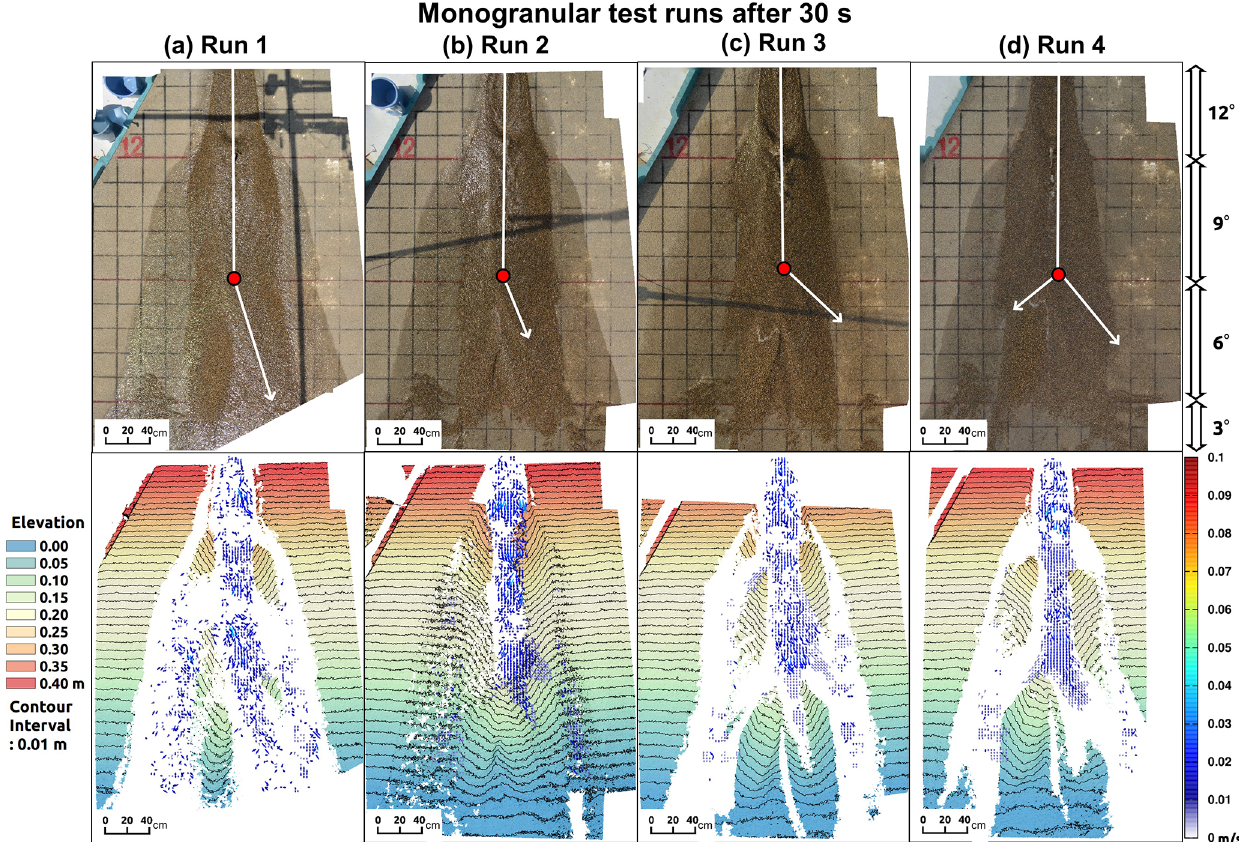
Figure 10. Fan morphology 30s after the start of runout of the monogranular flows. The upper and lower panels show orthophotos and digital elevation models (DEMs) with flow vectors, respectively. Respective sets of the upper orthophoto and lower DEM represent corresponding results of each experimental test run. The white arrows on the orthophotos indicate the assumed principal direction of flow descent. The red points in the orthophotos indicate the assumed occurrence point of the avulsion. The elevation of the DEMs is depicted assuming that the area with a 3 ◦ slope (i.e., the area furthest downstream from where the slope angle changed from a 6 to 3 ◦ slope) has elevation of